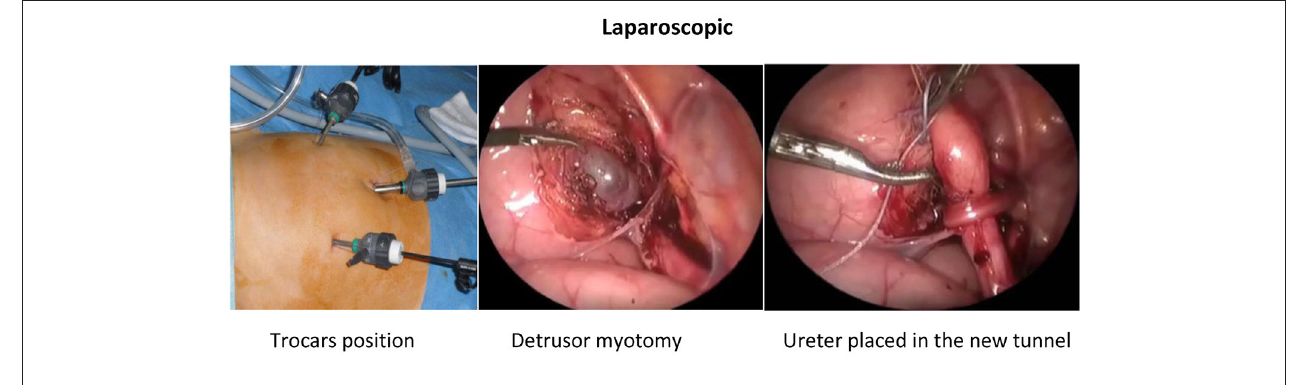
FIGURE 2 | Laproscopic.